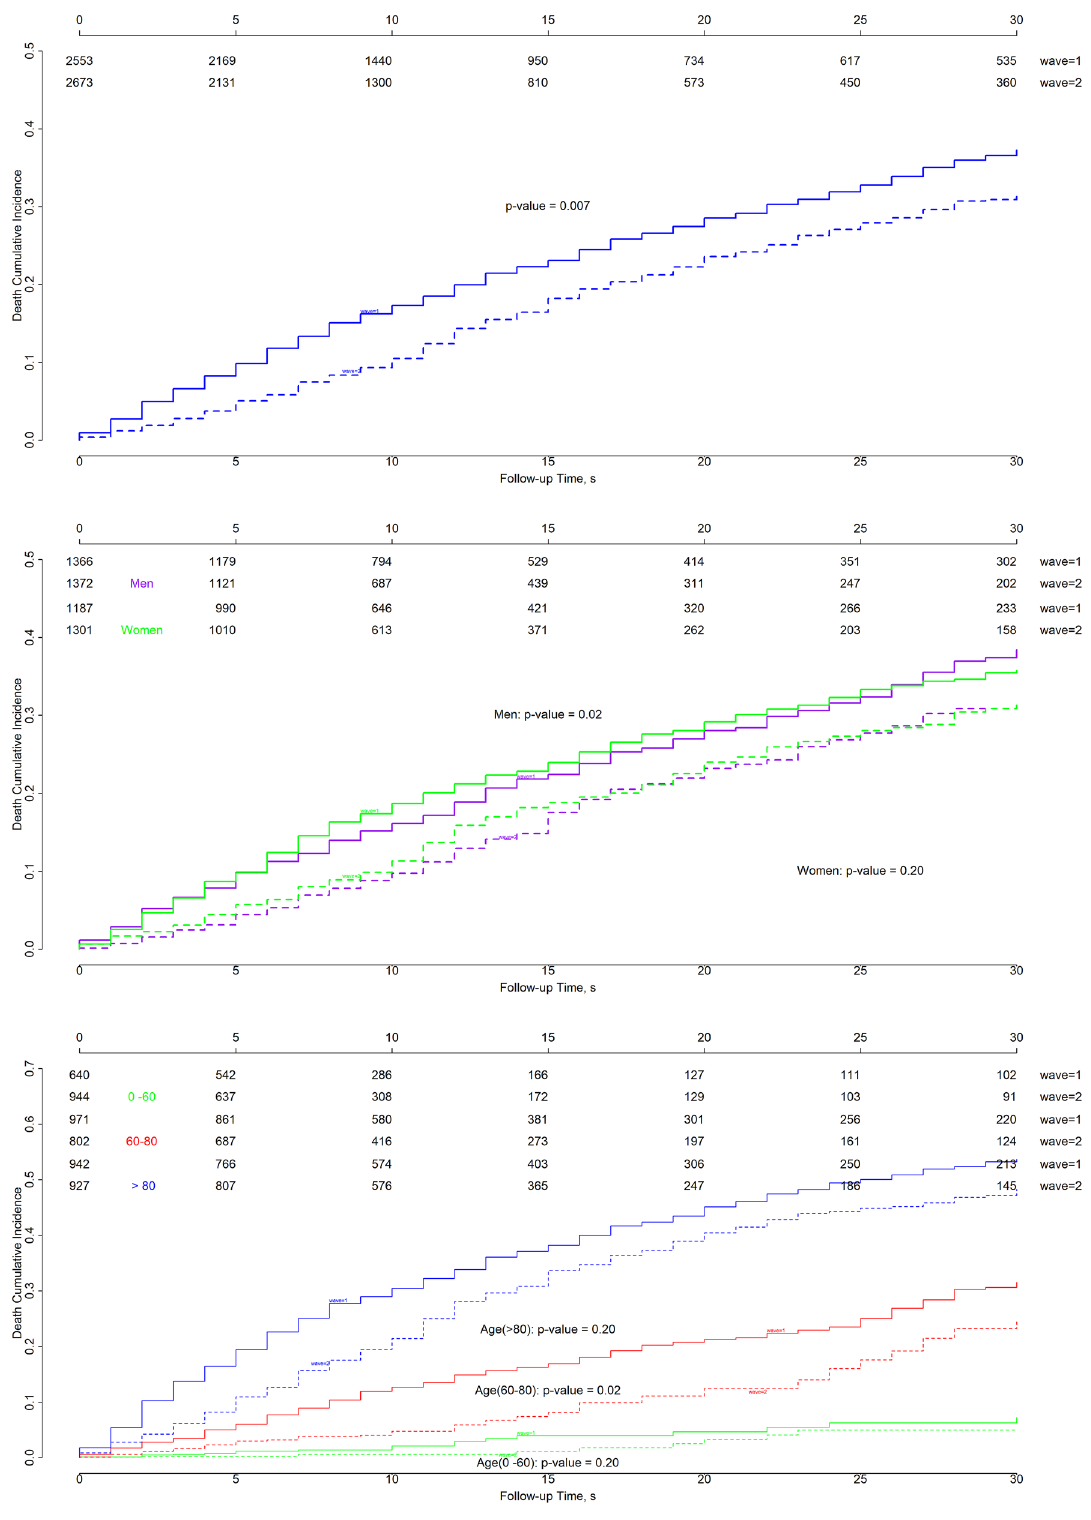
Figure 6. Cumulative incidence of death for all patients ( top) , patients stratified by sex ( middle ), and patients stratified by age ( bottom) in Aragon, Spain, February-September 2020. By sex: purple indicates men, green indicates women. By age: green indicates 0–60 years, red 60–80 years, and blue > 80 years. Solid lines : first wave; dashed lines : second wave. The p-values corresponds to the Gray test to compare survival curves between waves for groups stratified by sex or